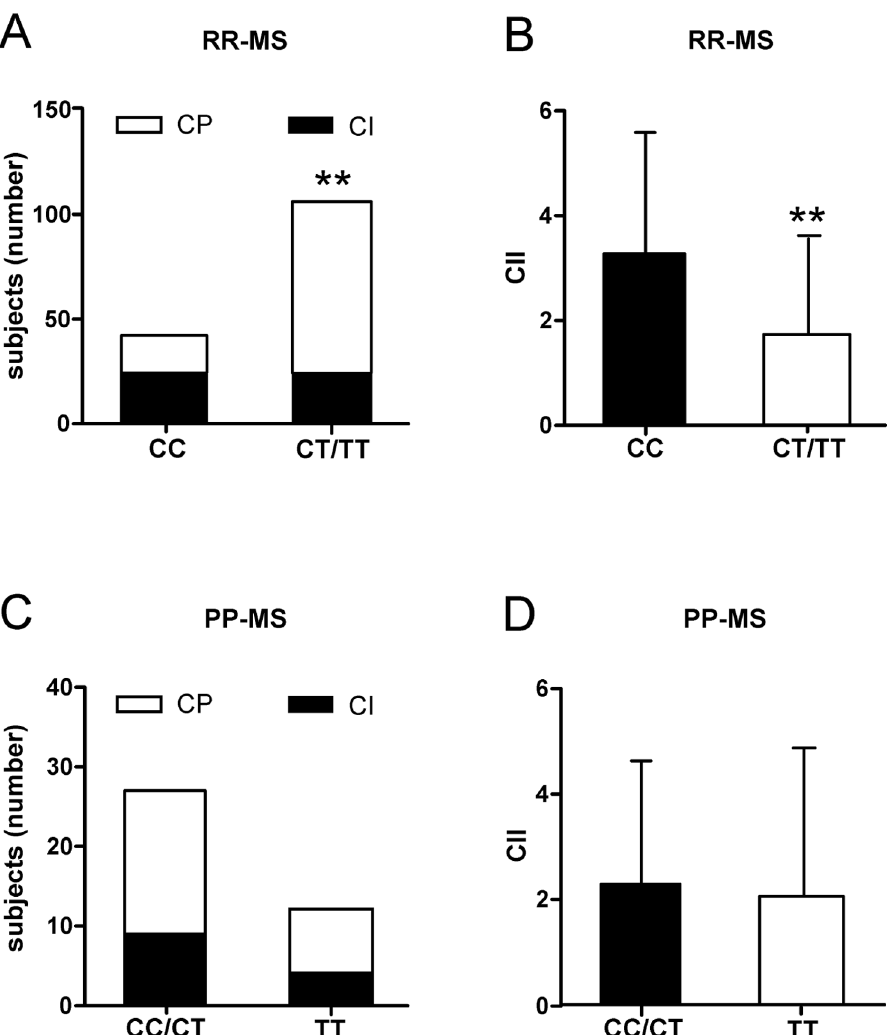
Figure 5. Effect of SNP rs4880213 on cognitive performances in MS. A. The graph shows that the frequency of cognitive preserved (CP) subjects, with at least five years of disease, was higher among RR-MS patients with T allele. B. The CII was lower among RR-MS patients with T allele. C. The graphs show that the frequency of cognitive impaired (CI) subjects was not higher among PP-MS subjects homozygous for T allele. D. The CII was not significantly higher among PP-MS subjects homozygous for T allele. ** means p ,